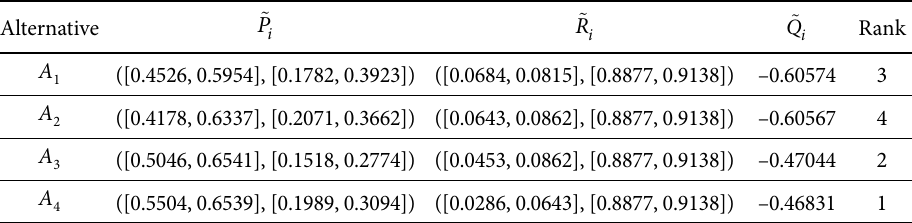
Table 1. The values of i P  , i R  and i Q  taking into account